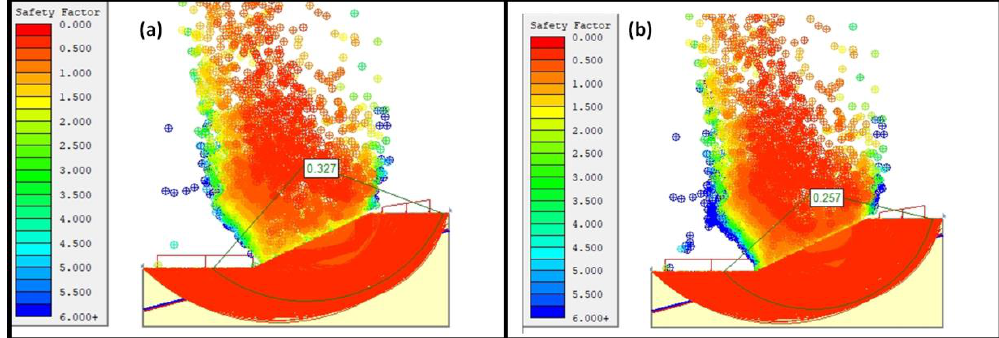
Figure 29. Safety factor simulated for drained to undrained conditions in clay loam soil slope using ( a ) Corp of Engineers’ Number Two method and ( b ) the Lower Karafiath method. Appl. Sci. 2020 , 10 , x FOR PEER REVIEW 25 of 33